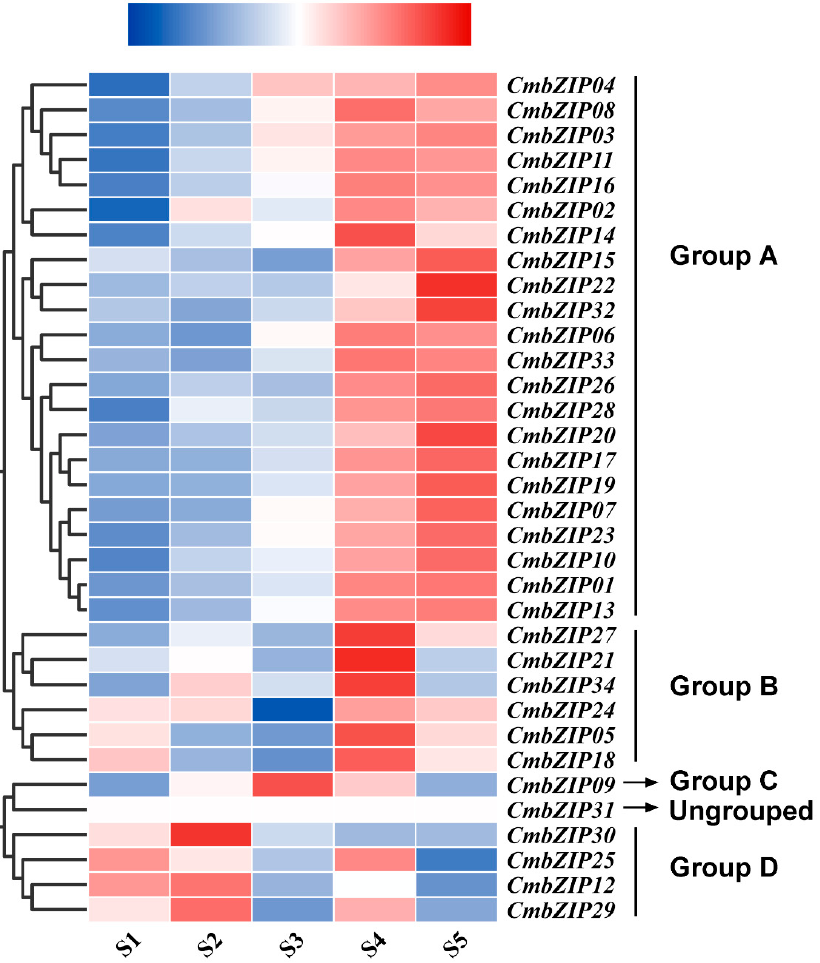
Figure 7. Expression profiles of CmbZIP genes under di ff erent stages of conidial development. S1: hyphal growth stage (48 hpi), S2: primordial formation stage (60 hpi), S3: pycnidial initiation stage (72 hpi), S4: pycnidial formation stage (84 hpi), S5: pycnidial maturation stage (96 hpi). Relative expression values of RT-qPCR results were transformed by log2. Blue and red boxes indicate lower and higher expression levels,